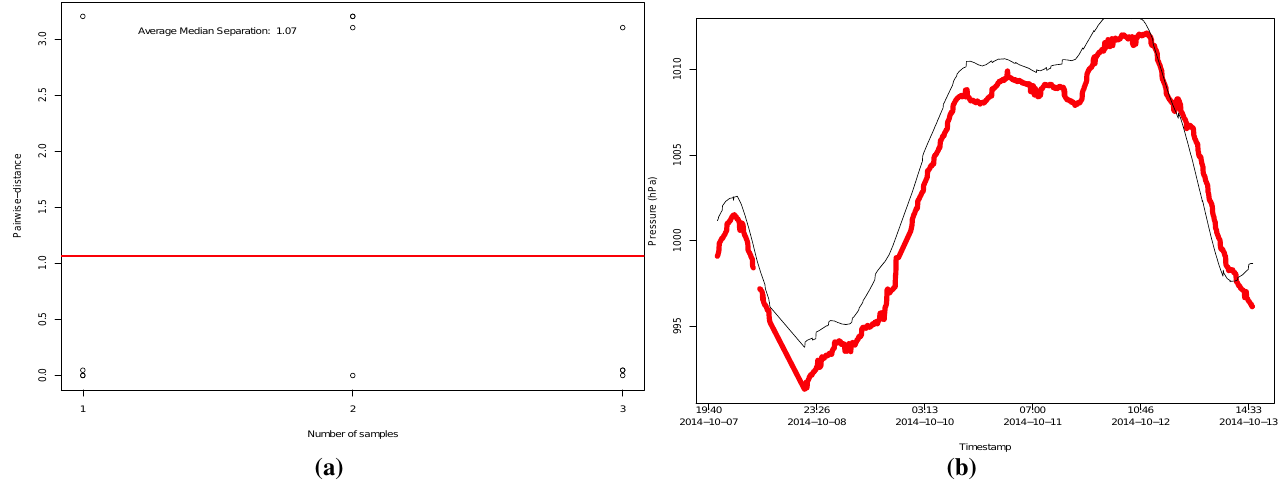
Figure 13. Analysis of pressure data from sensors in a range of 100 km from the coordinates of London, UK, in Dataset 2, considering a limit of r ≥ 0 . 7 . ( a ) Pairwise-distances for pressure sensors; ( b ) Estimation of the pressure, resulting in a MSE = 2 . 66978